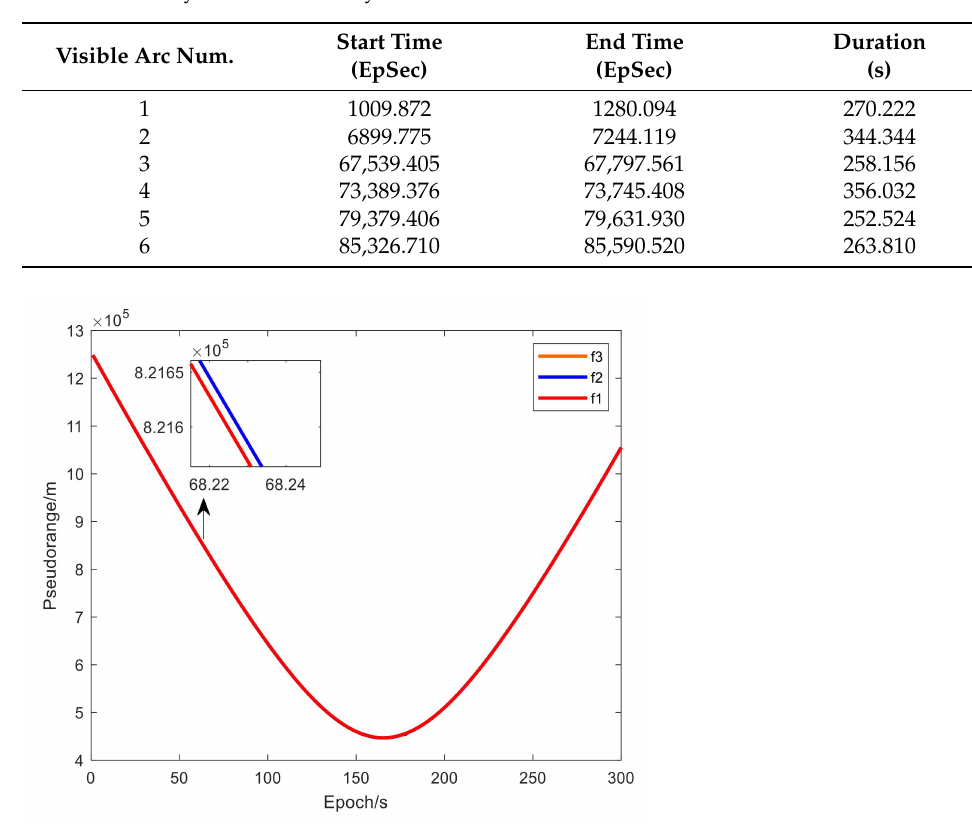
Figure 4. Pseudo-range data obtained by